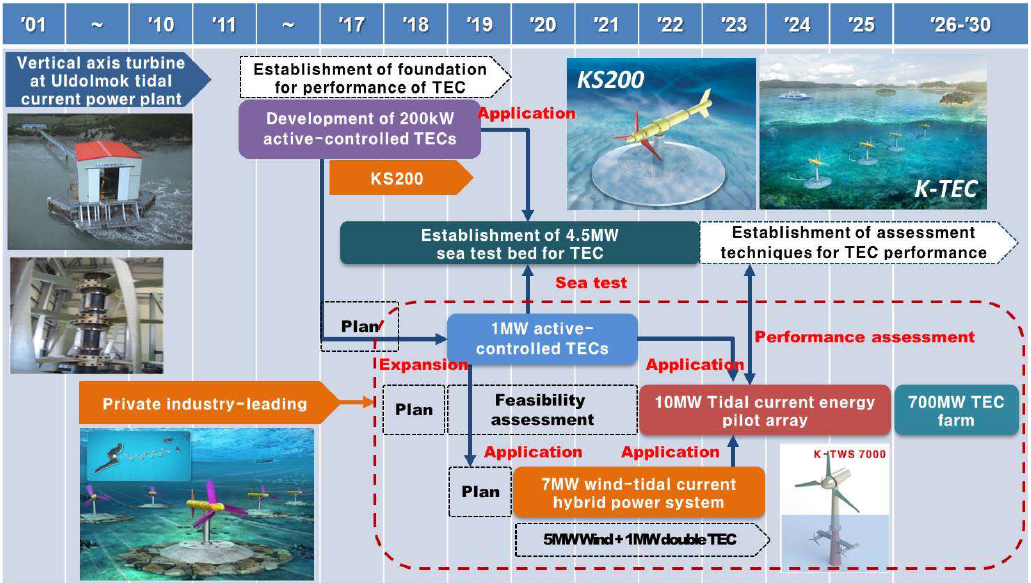
Figure 5. Timeline for tidal current energy research performed by the KIOST.